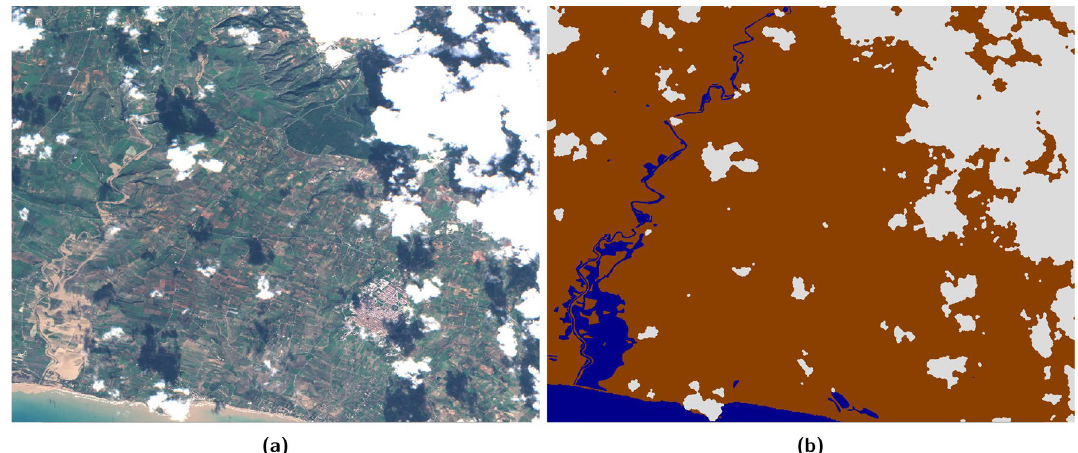
Figure 4. ( a ) Sentinel 2 RGB bands and ( b ) associated labelled map (land/brown, water/blue, cloud/white) over Porto Palo (Sicily) derived from Copernicus EMS 333 activation. Cloud mask obtained automatically with s2cloudless 49 . Base image and reference labels are included in the WorldFloods database and code for plotting this images may be found in our repository 6 .